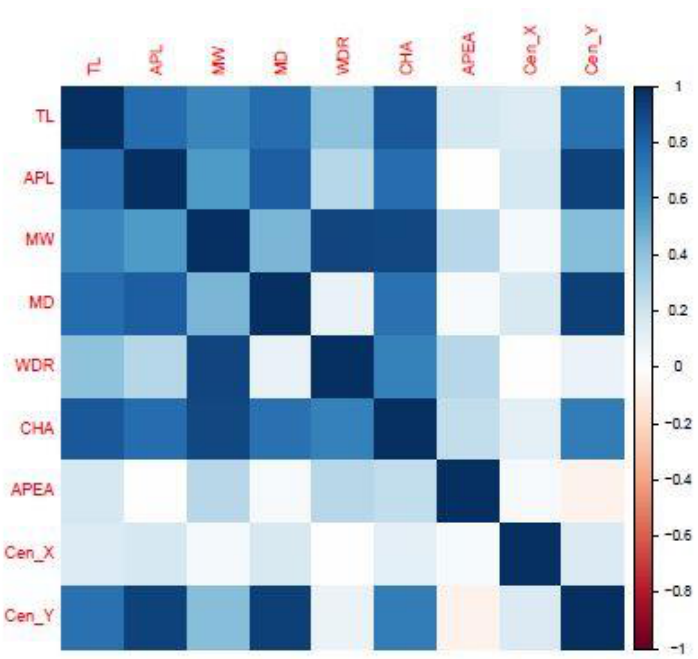
Figure 6. Correlation matrix of the measured root traits.